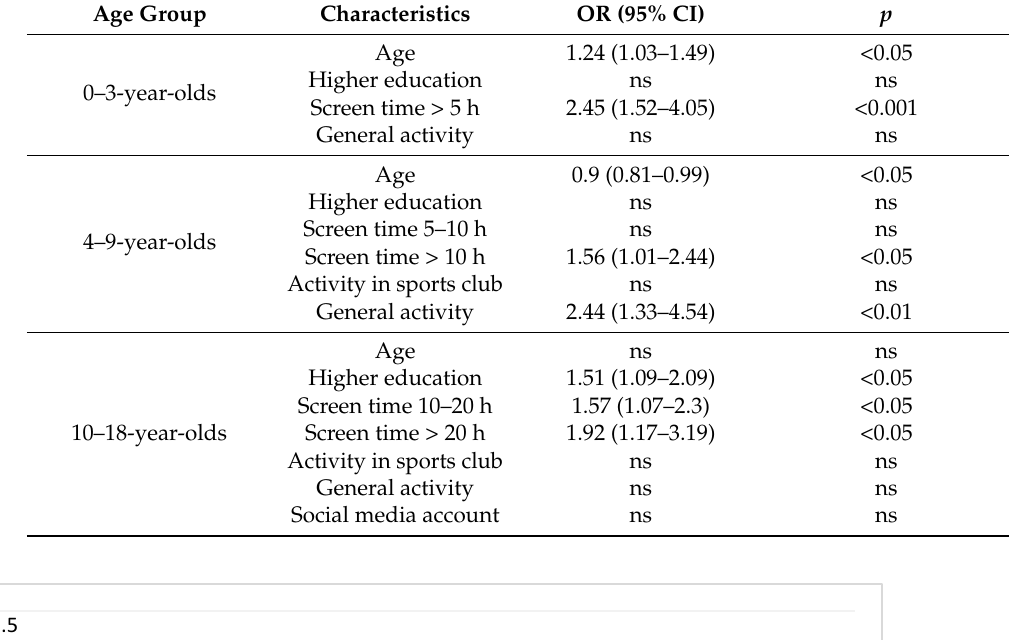
Table 3. Multivariable analysis for identifying the potential association between age, education of parents, screen time, general activity of the child, child’s activity in sports club, the use of social media, and the purchase of supplements or food to promote health in the different age groups.